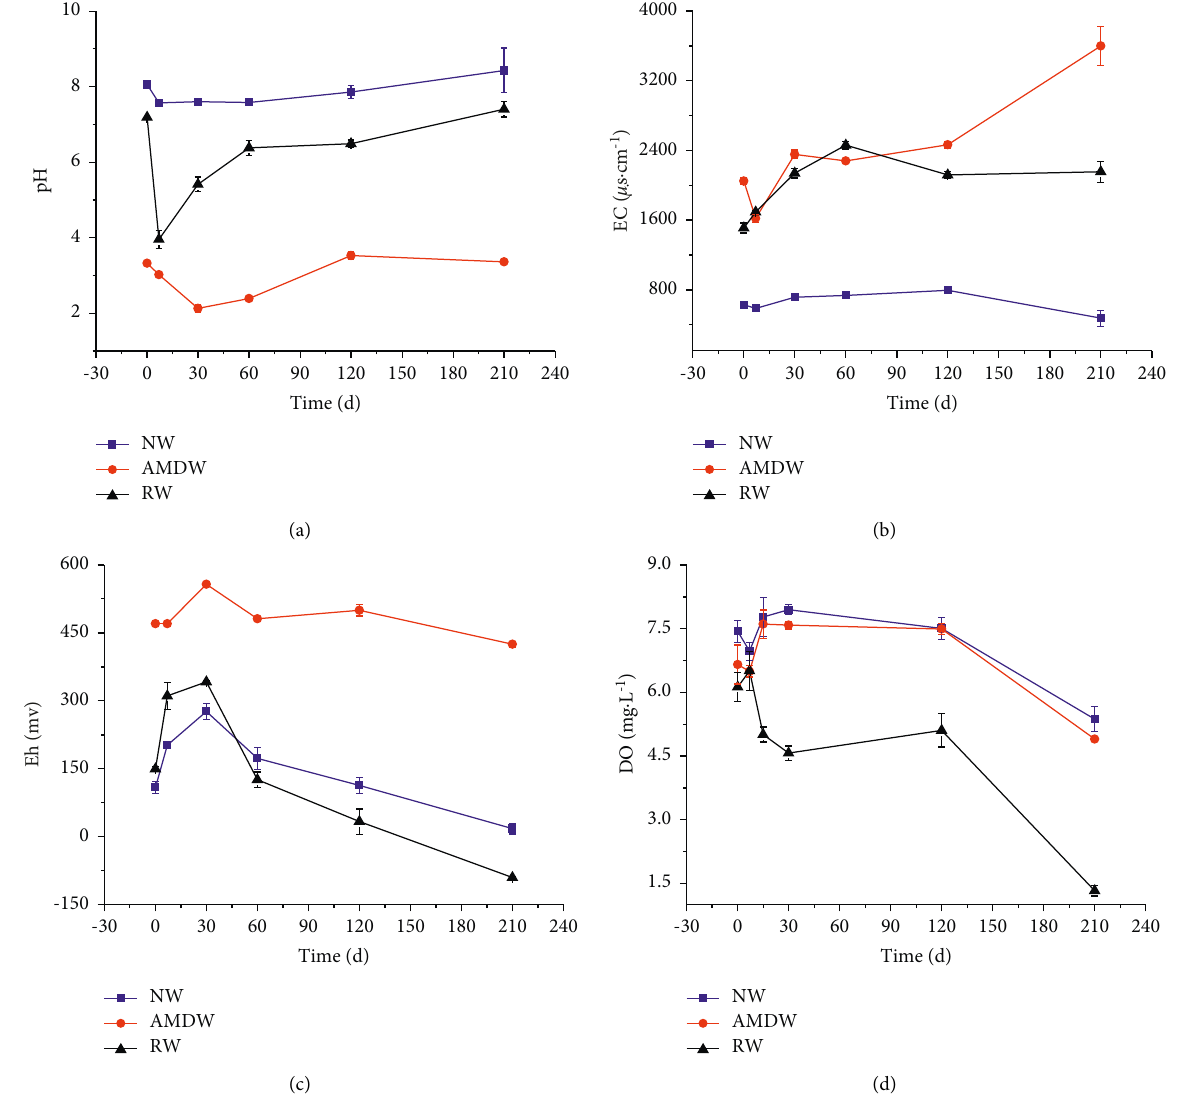
Figure 3: The temporal variation of pH, EC, Eh, and DO in NW, RW, and